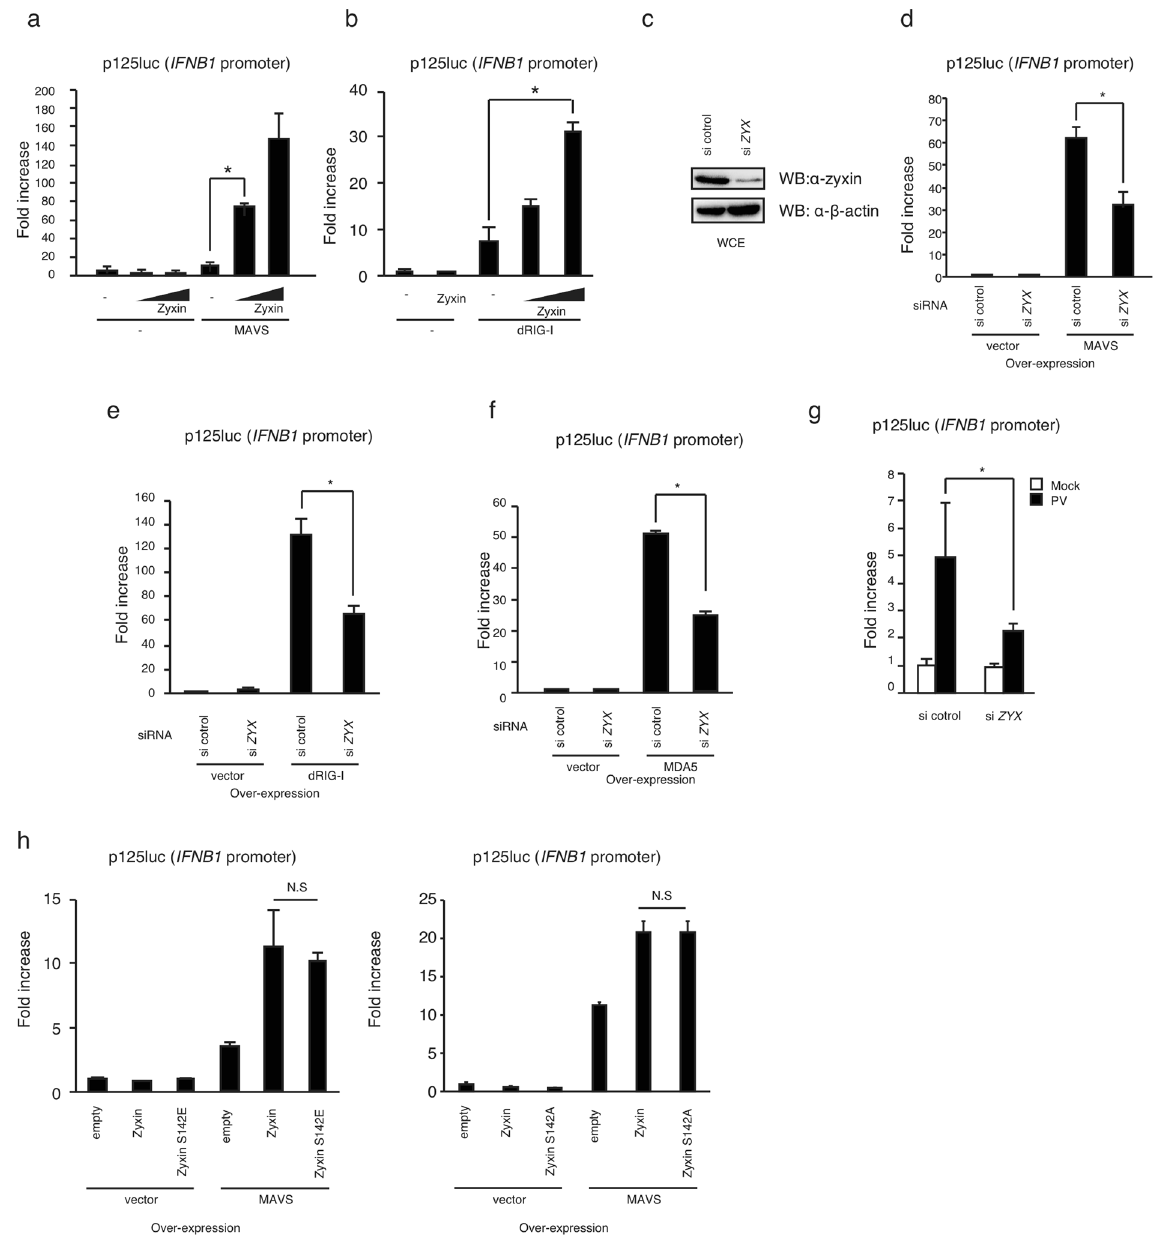
Figure 3. Zyxin promotes MAVS-mediated IFNB1 promoter activation. ( a , b ) HEK293 cells were transfected with an empty vector or plasmids encoding MAVS ( a ), dRIG-I ( b ), and/or zyxin (0.1 μ g, 0.3 μ g) together with p125 luc ( IFNB1 ) and Renilla luciferase vectors. Cells were lysed 24 h after transfection and reporter activities were determined by luciferase assay; luciferase activities were normalized to Renilla luciferase activity (internal control). Fold increase was calculated by dividing each value by the empty vector control. ( c ) siRNA for ZYX or negative control were transfected into HEK293 cells for 48 h. Cell lysates were prepared and were subjected to SDS-PAGE. Proteins were detected by western blotting with anti-zyxin and anti- β -actin antibodies. The original full blot images can be found in Supplemental Fig. 2. ( d – f ) siRNA for ZYX or negative control were transfected into HEK293 cells with MAVS (0.1 μ g) ( d ), dRIG-I (0.1 μ g) ( e ), or MDA5 (0.1 μ g) ( f ) expression vectors and reporter plasmids (p125luc and Renilla luciferase) for 48 h. The fold increase was determined as described in ( a ). ( g ) Cells were transfected with siRNA for ZYX or negative control together with reporter plasmids (p125luc and Renilla luciferase). Two d after transfection, cells were infected with poliovirus (MOI = 1) for 24 h. Cells were lysed, and the fold increase was determined as described in ( a ). ( h ) HEK293 cells were transfected with MAVS, wild-type zyxin, a phospho-mimetic zyxin mutant (Zyxin-S142E), and phospho-deficient zyxin mutant (Zyxin-S142A) together with reporter plasmids (p125luc and Renilla luciferase). The fold increase was determined as described in ( a ). The data represent means ± SD, and the date are representative at least 2 independent experiments. * p < 0.05 (one-way ANOVA). “N.S.” represents not